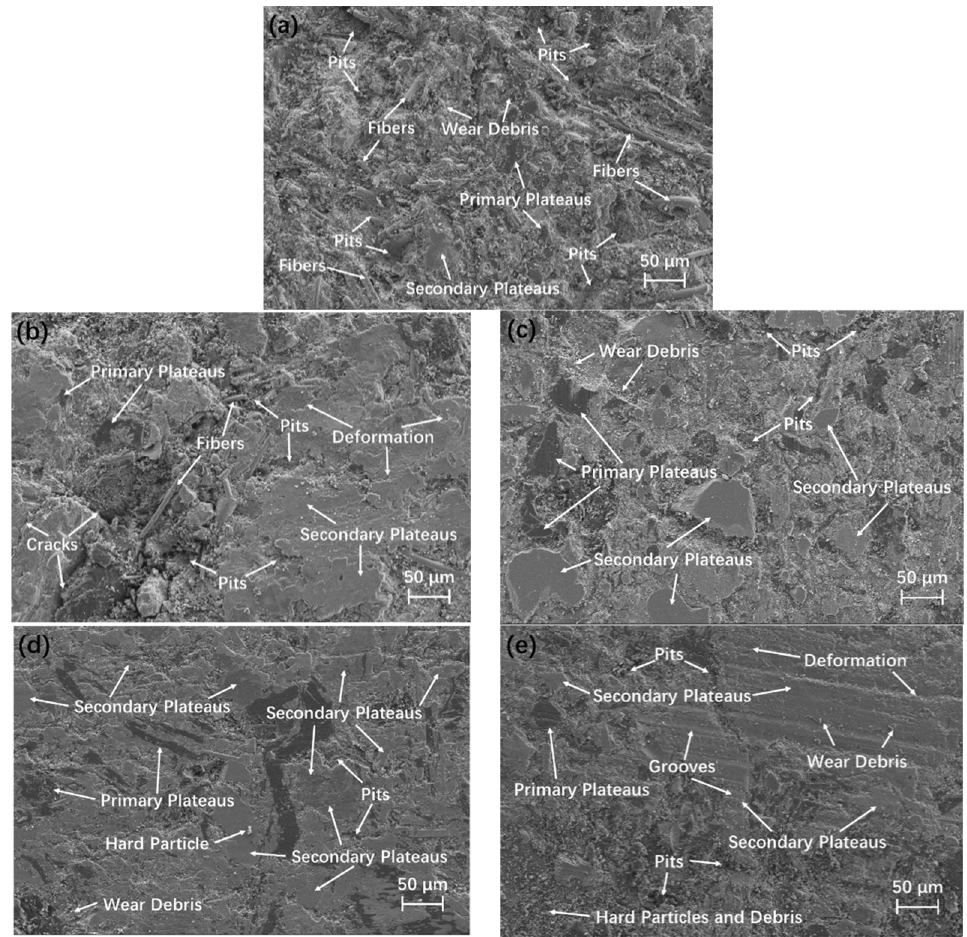
Figure 11. SEM micrographs of the worn surface; ( a ) RBFM-1, ( b ) RBFM-2, ( c ) RBFM-3, ( d ) RBFM-4, ( e ) RBFM-5.